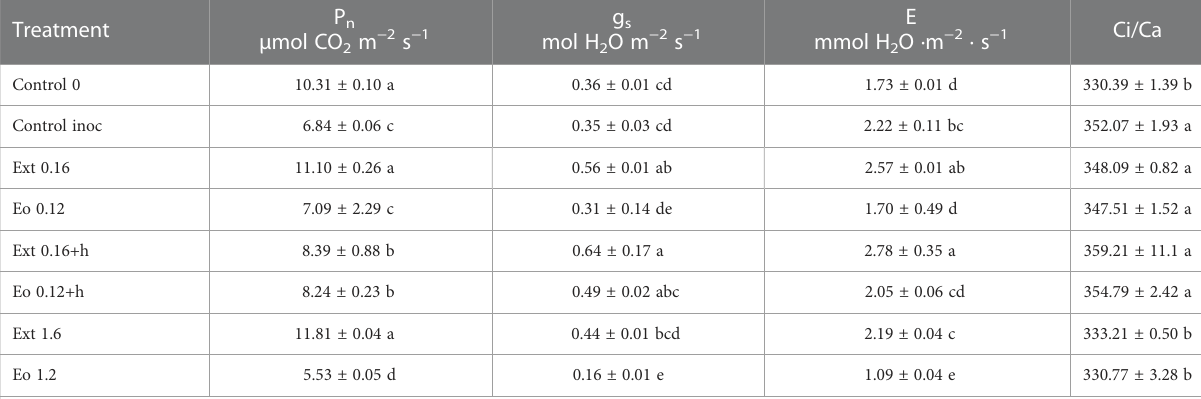
Values are mean±SE of 3 replicates. Different letters indicate signi fi cant differences between the means of the treatments (Tukey ’ s signi fi cant difference test, p< 0.05).